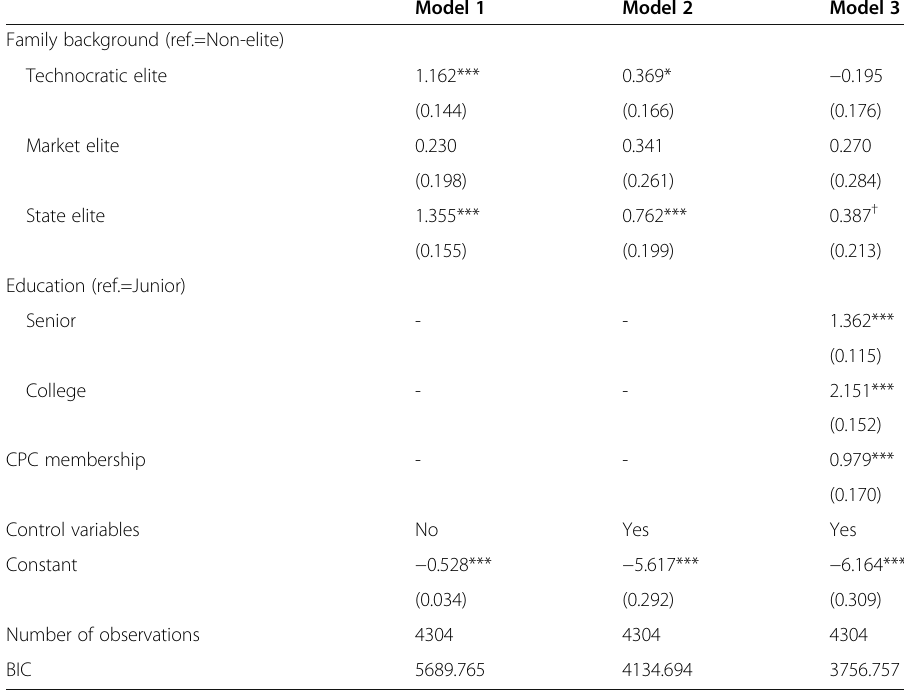
Table 2 Multinomial logistic regression analysis of the determinants of first job